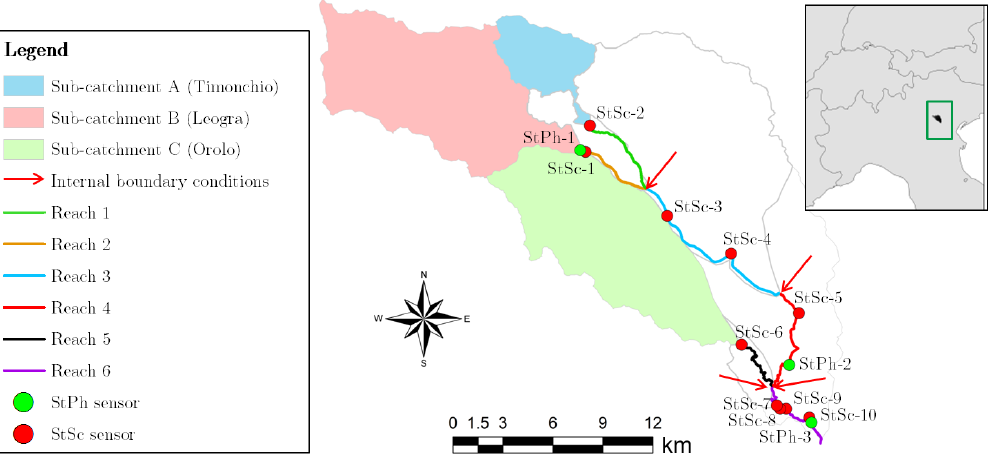
Figure 1. Spatial distribution of the sub–catchments, river reaches, and StPh and StSc sensors implemented in the catchment by AAWA. The prediction point of Ponte degli Angeli (PA) corresponds to the StPh-3